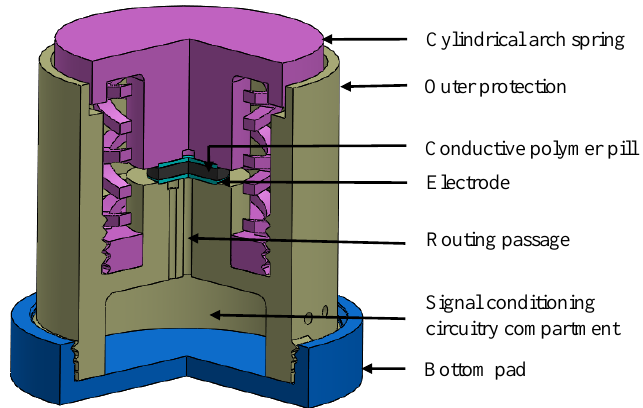
Figure 1. A three-quarter view section of the proposed force sensor design.